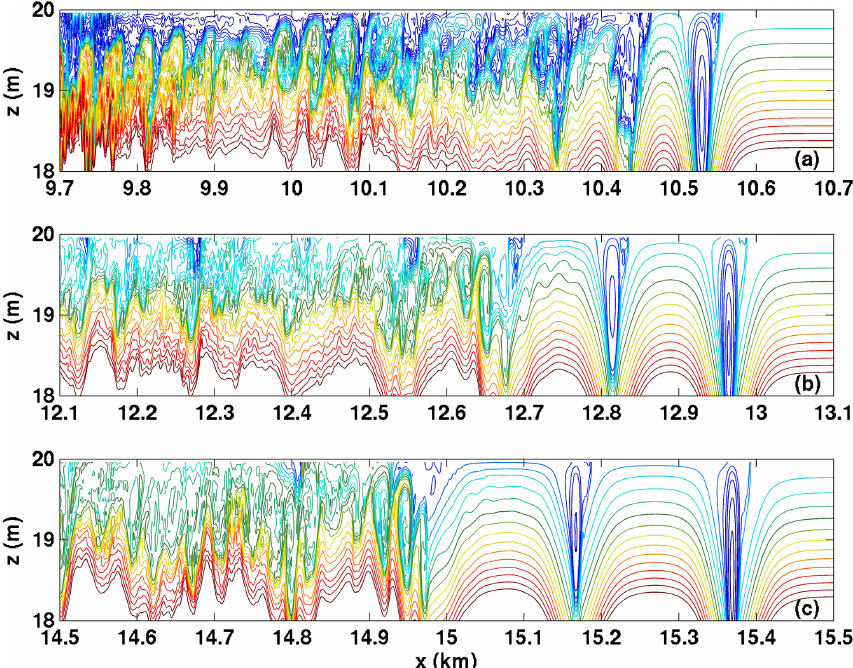
Figure 8. Detail of density fields in the core region for wave trains propagating with the shear current for Case NO DJL 1. Twenty-one density isolines with values − 5 × 10 − 4 < ρ < − 4 × 10 − 4 shown. (a) t = 7200s, (b) t = 14400s, and (c) t =